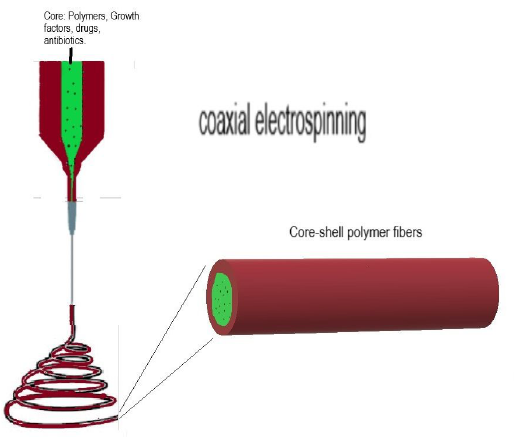
Figure 4: Schematic representation of coaxial